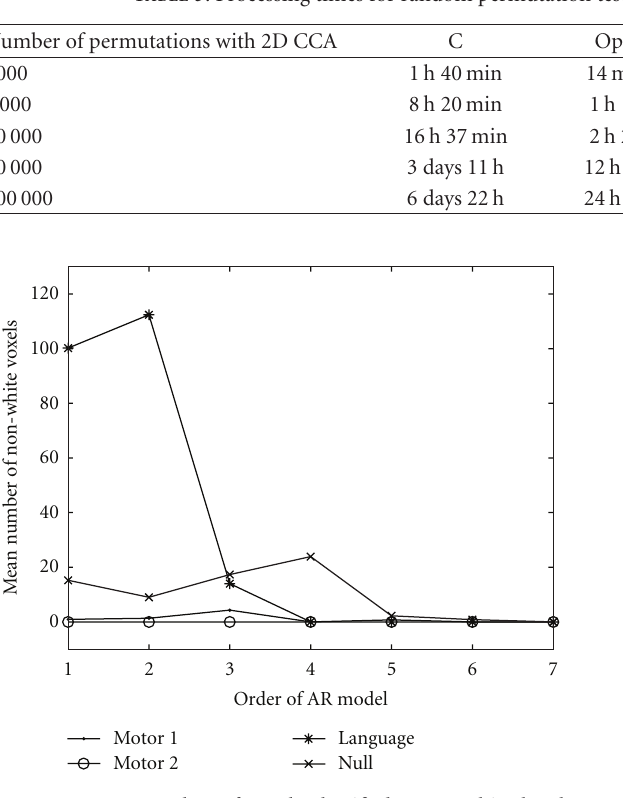
Figure 5: Mean number of voxels classified as nonwhite by the Ljung-Box test (1–10 time lags were tested and the mean number of nonwhite voxels for the 10 tests was saved). Prior to the Ljung- Box test the estimated auto correlations were spatially smoothed. The number of nonwhite voxels for Gaussian white noise is always zero.